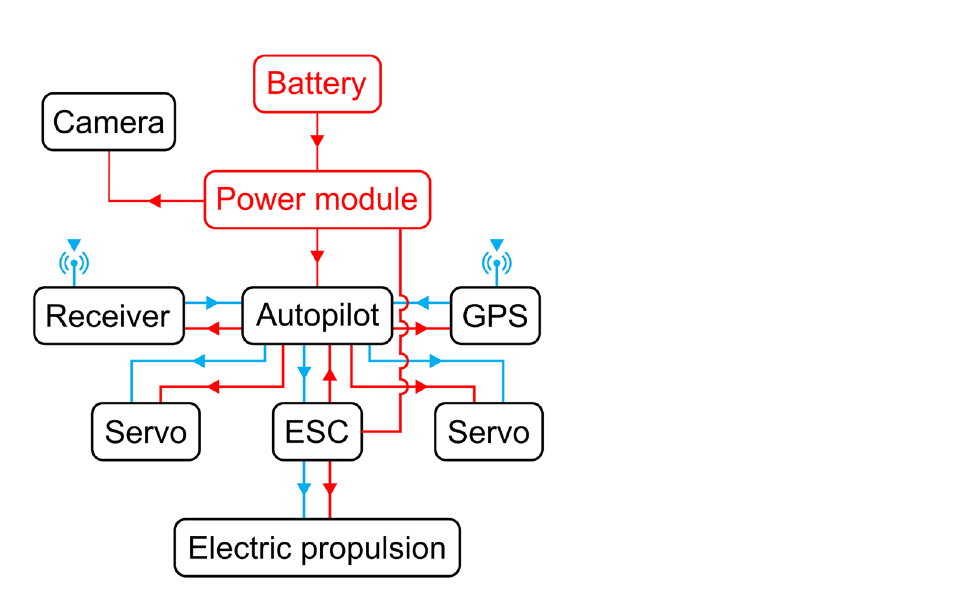
Figure 19. Embarked components for autonomous flight configuration including autopilot and